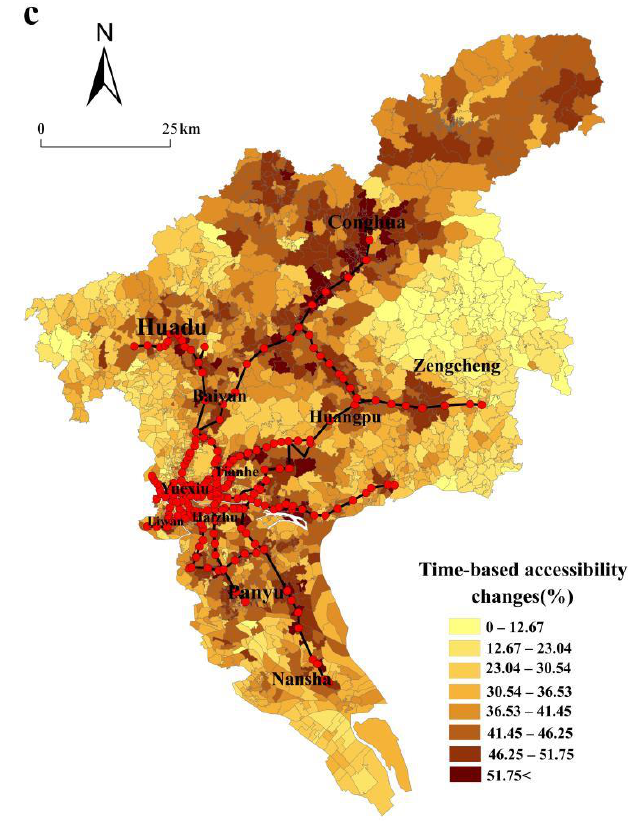
Figure 4. The spatial distribution of the time-based accessibility of communities in bus-only scenario ( a ), in bus and rail transit scenario ( b ), and accessibility changes between the two scenarios ( c ). The spatial pattern of time-based accessibility is slightly reversed with the rail transit